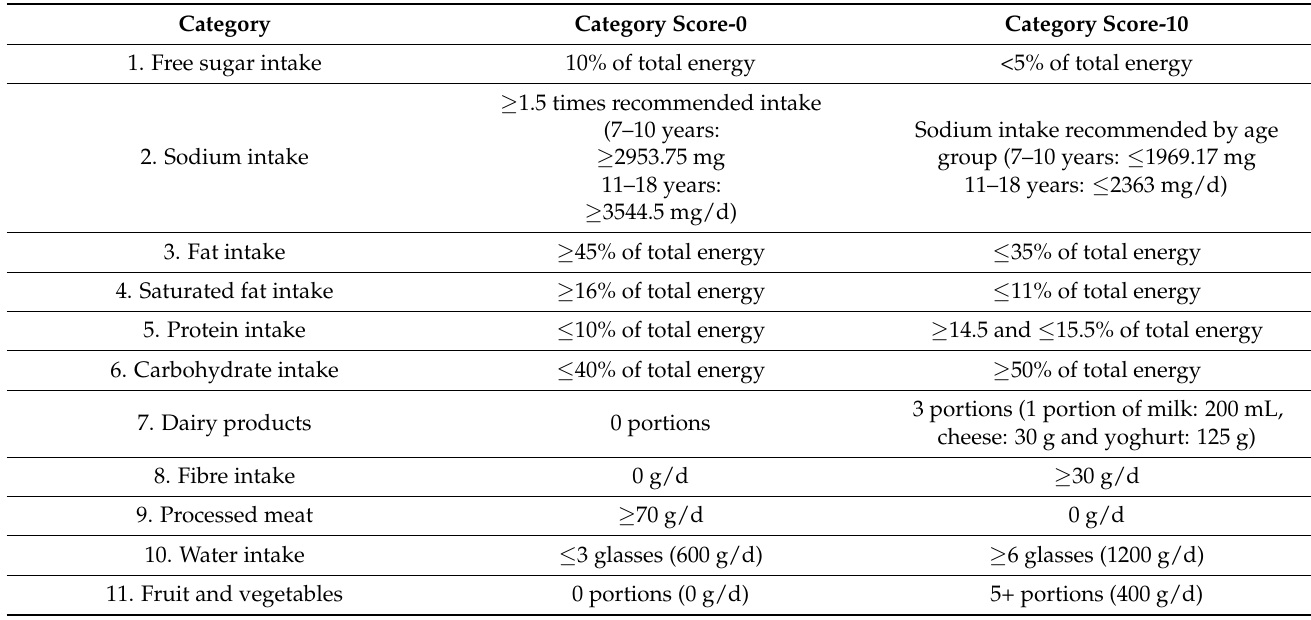
Table 2. Intake criteria required for the lowest and highest category scores (0 and 10 respectively). Dairy portion sizes retrieved from the Portion sizes: Food Fact Sheet. British Dietetic Association